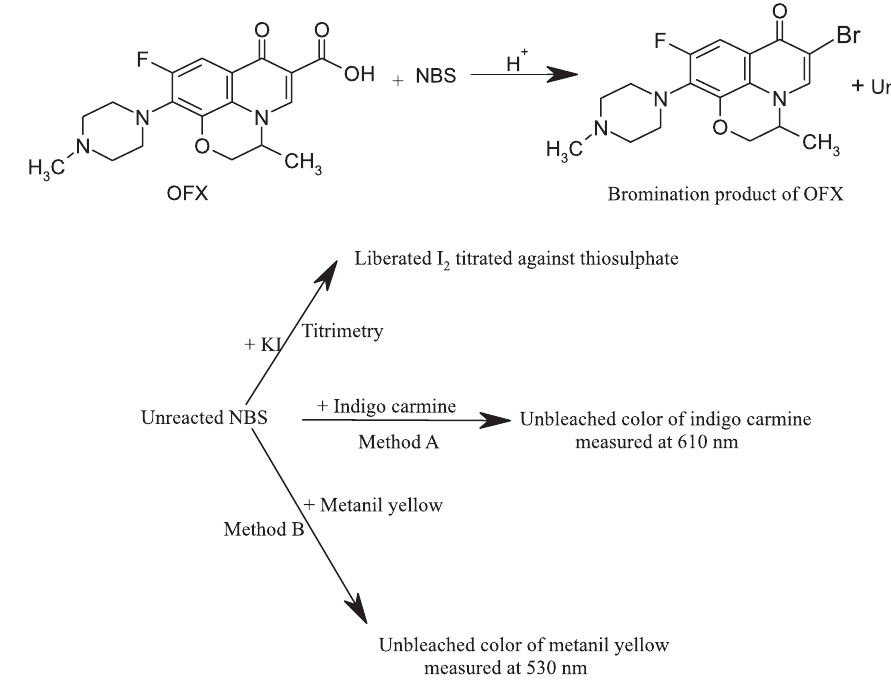
SCHEME I - Tentative reaction scheme for titrimetry, spectrophotometric method A and method